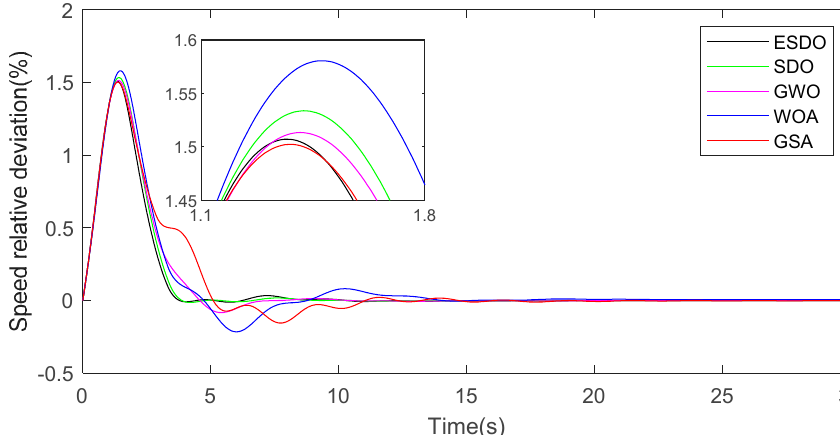
Figure 17. Speed response curves with 12% load.